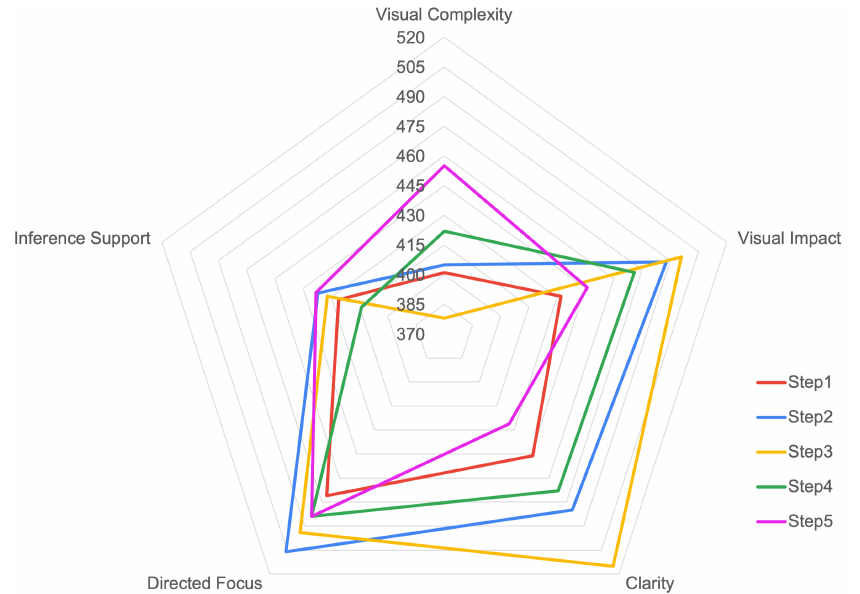
Figure 10. Sum of participants ratings for the visual characteristics of the step-by-step instruc- tions, according to: Visual Complexity (VC), Visual Impact (VI), Clarity (CLA), Directed Focus (DF) and Inference Support (IS).